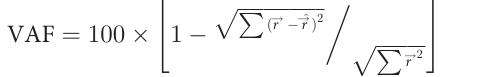
p" p (cid:3) ffiffiffiffiffiffiffiffiffiffiffiffiffiffiffiffiffiP ð r ! (cid:2) r ! ^ Þ 2